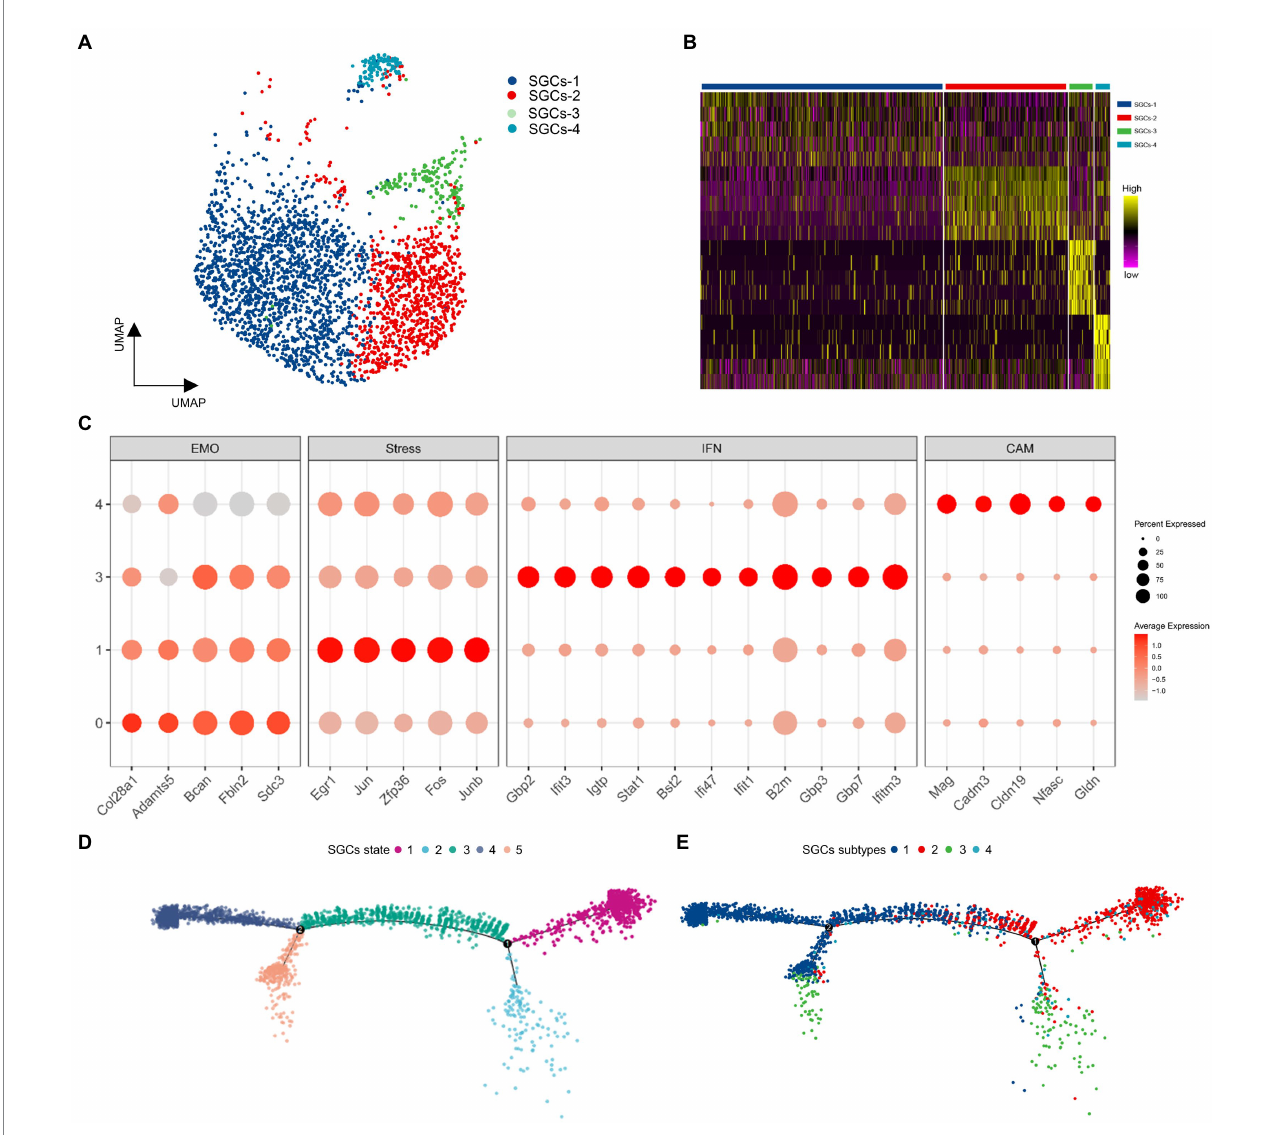
FIGURE 6 The analysis of SGCs subtypes in TG. (A) The UMAP plot of SGCs subtypes in TG. Number of cells for the SGCs subtypes: SGCs-1 (1685), SGCs-2 (861), SGCs (171), SGCs-4 (110). (B) The gene heat map of SGCs subtypes in TG. (C) The dot plots of SGCs enriched transcripts. EMO: extracellular matrix organization-related genes, Stress: early immediate genes, IFN: interferon response-related genes, CAM: cell adhesion molecule-related genes. (D) Pseudotime trajectory analysis of SGCs. The five states of SGCs are arranged along the trajectory. (E) Pseudotime trajectory analysis of SGCs. The four subtypes of SGCs are arranged into the trajectory